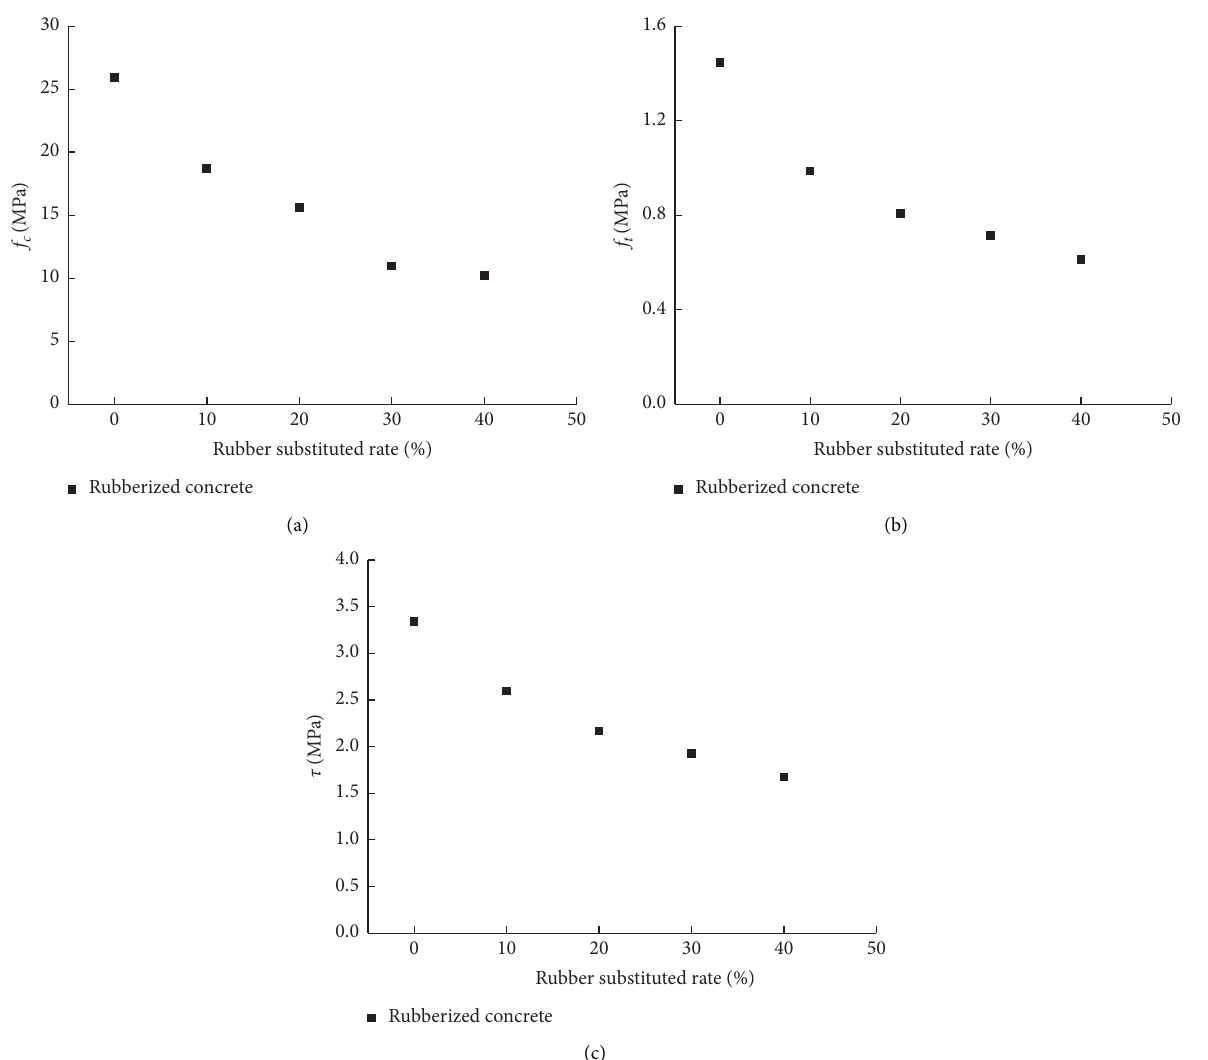
Figure 10: Effect of rubber substitution rate on the ultimate strength eigenvalue of rubber concrete. (a) Uniaxial compression, (b) uniaxial splitting, and (c) pure